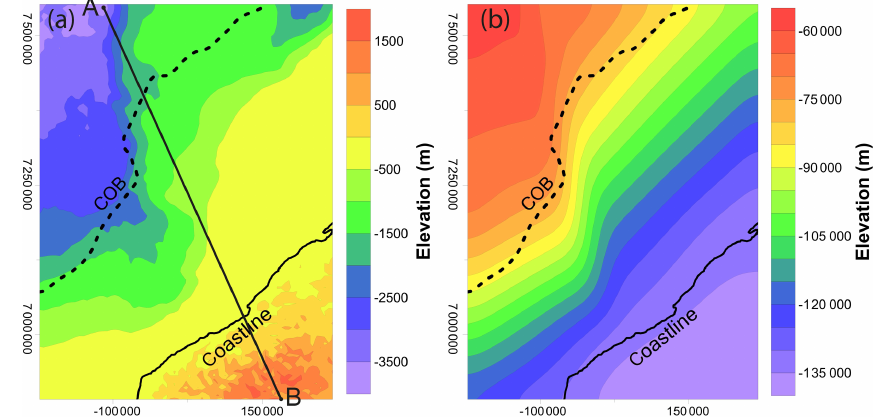
Figure 7. Surfaces with a fixed temperature for which the thermal boundary conditions were assigned in the Norwegian thermal model: (a) topography–bathymetry corresponding to the upper thermal boundary condition (2 ◦ C); (b) depth of the LAB utilized as the lower thermal boundary condition (1300 ◦